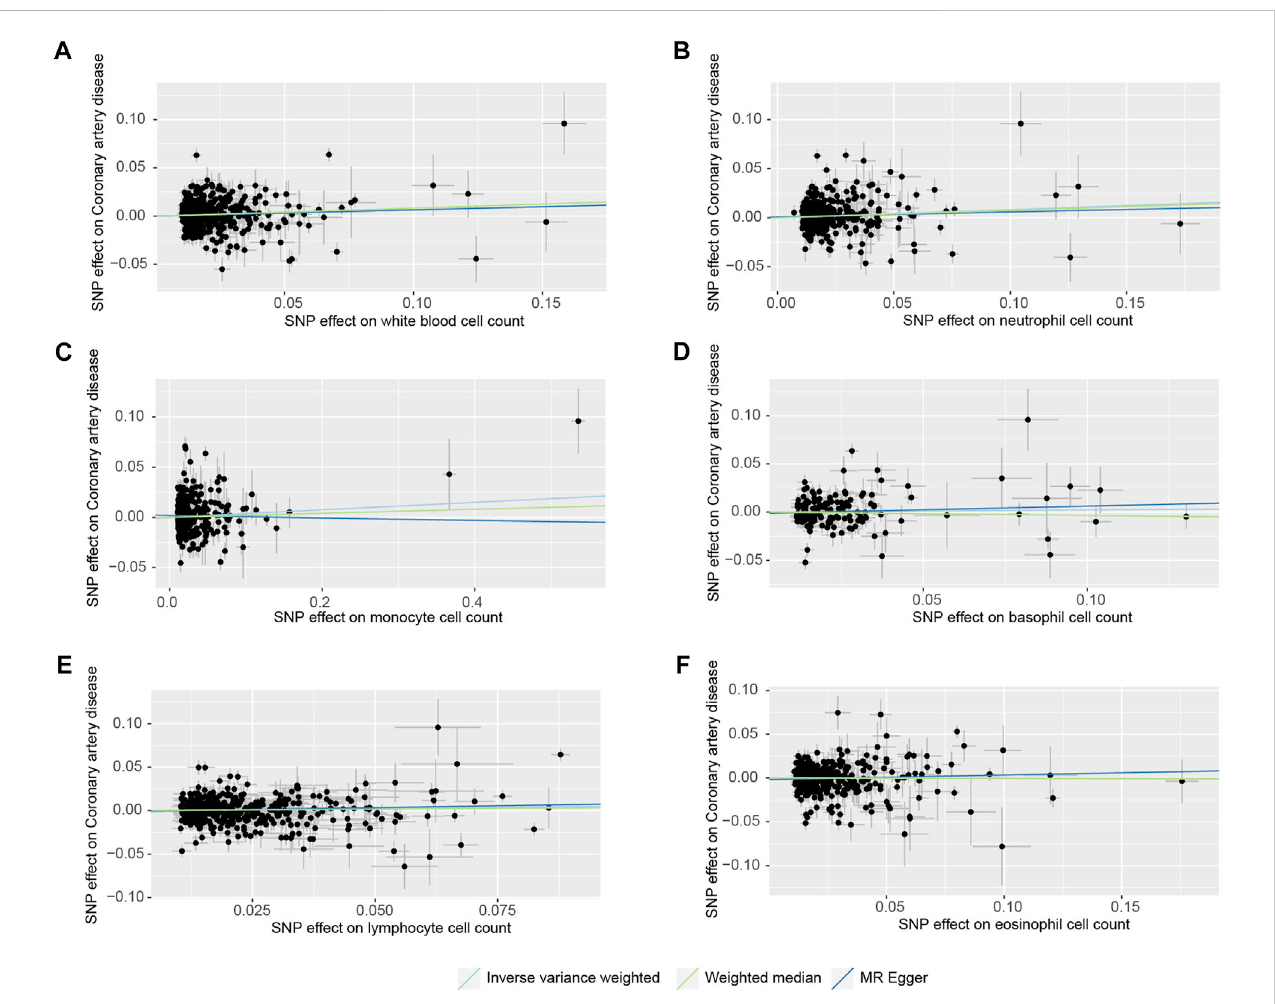
FIGURE 2 Scatter plots of the SNP effects on the blood cell count and coronary heart disease risk. (A) , white blood cell count; (B) , neutrophil cell count; (C) , monocyte cell count; (D) , basophil cell count; (E) , lymphocyte cell count; (F) , eosinophil cell count). Regression lines represent the causal effect of the blood cell count on coronary heart disease risk using IVW, MR-Egger, and Weighted median to estimate.